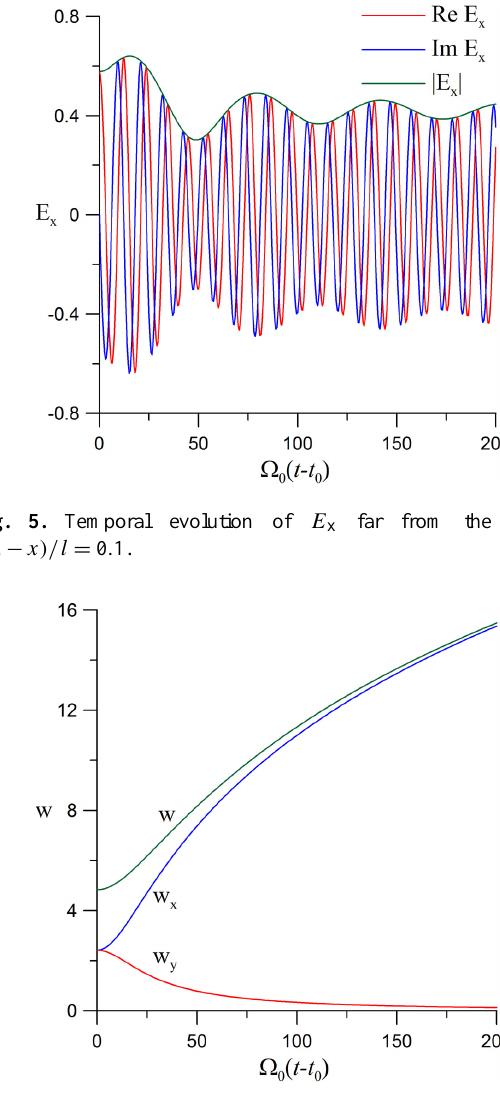
Fig. 6. Temporal evolution of wave energy density, w , and its com- ponents, w x and w y , on the surface of the impulse x 0